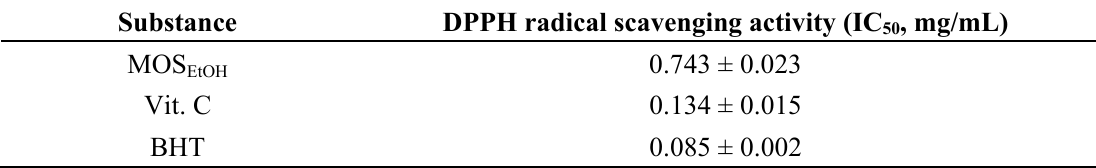
values of MOS 50